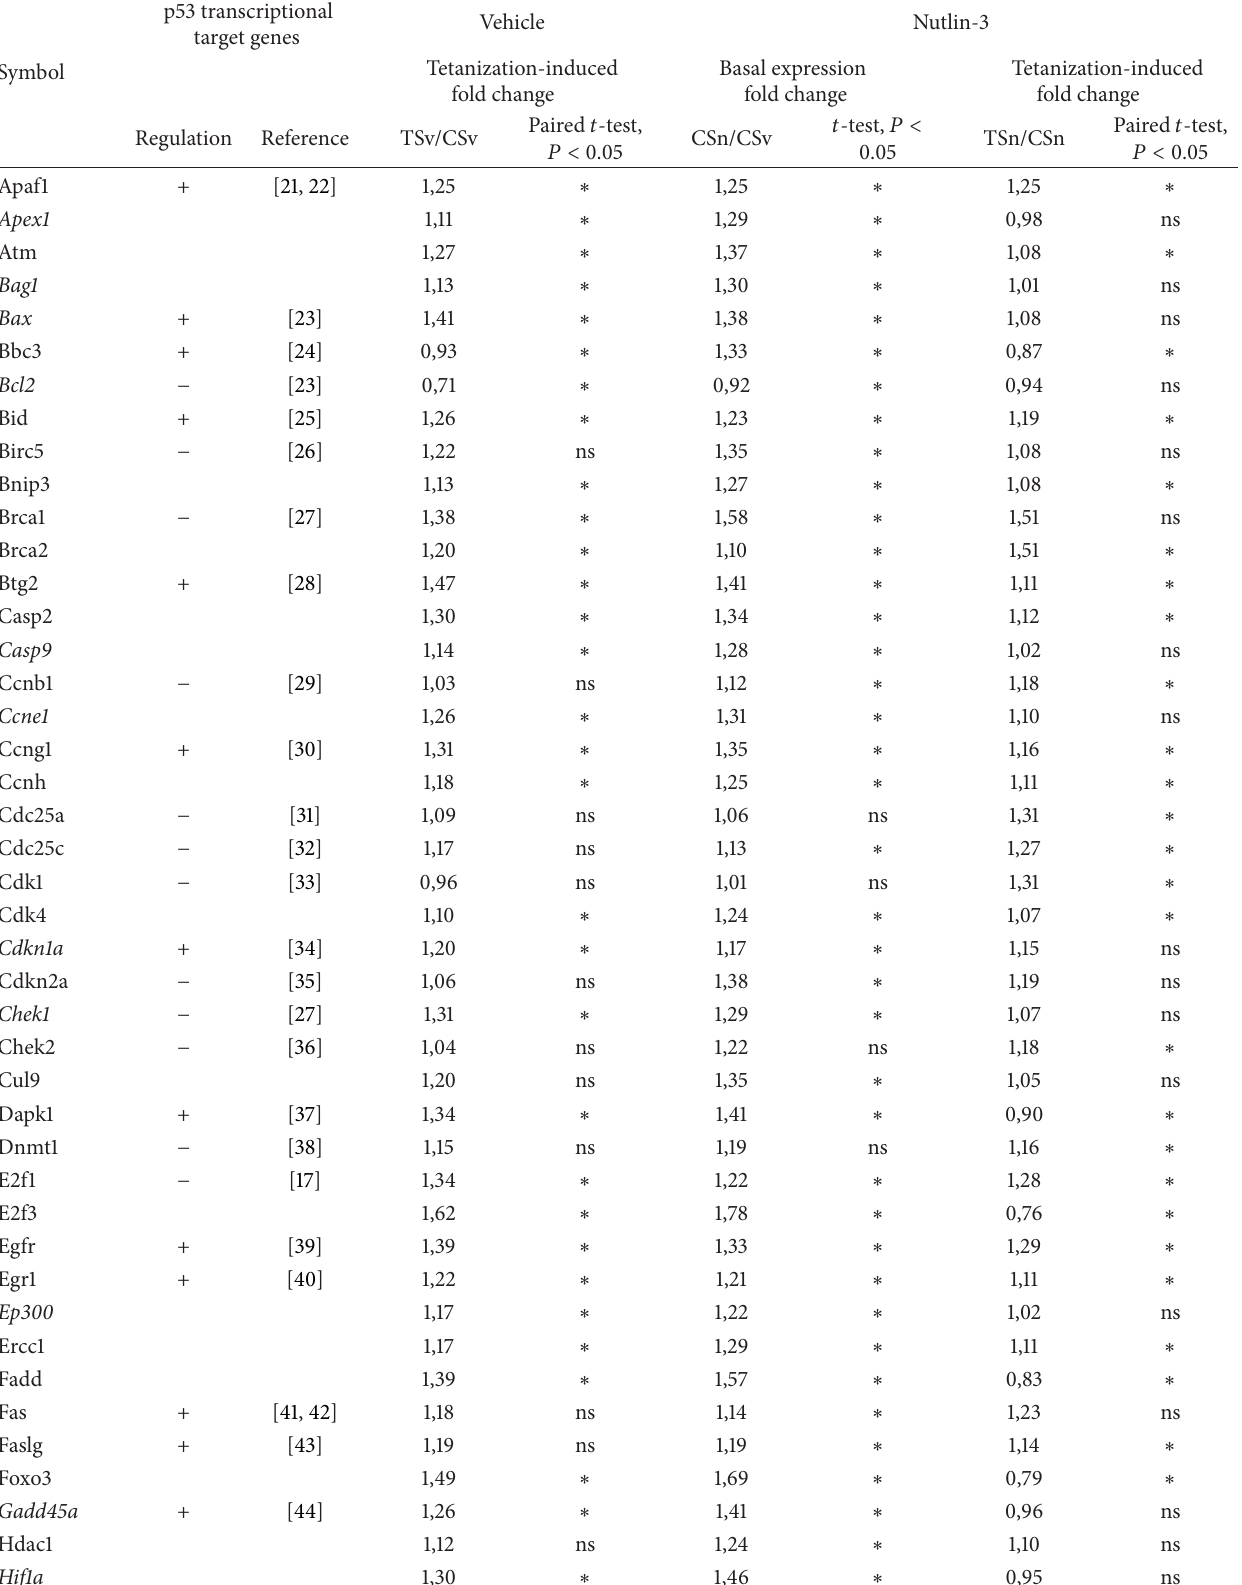
Table 1: Expression of p53-related genes in rat hippocampal CA1 area 30 min after tetanization.